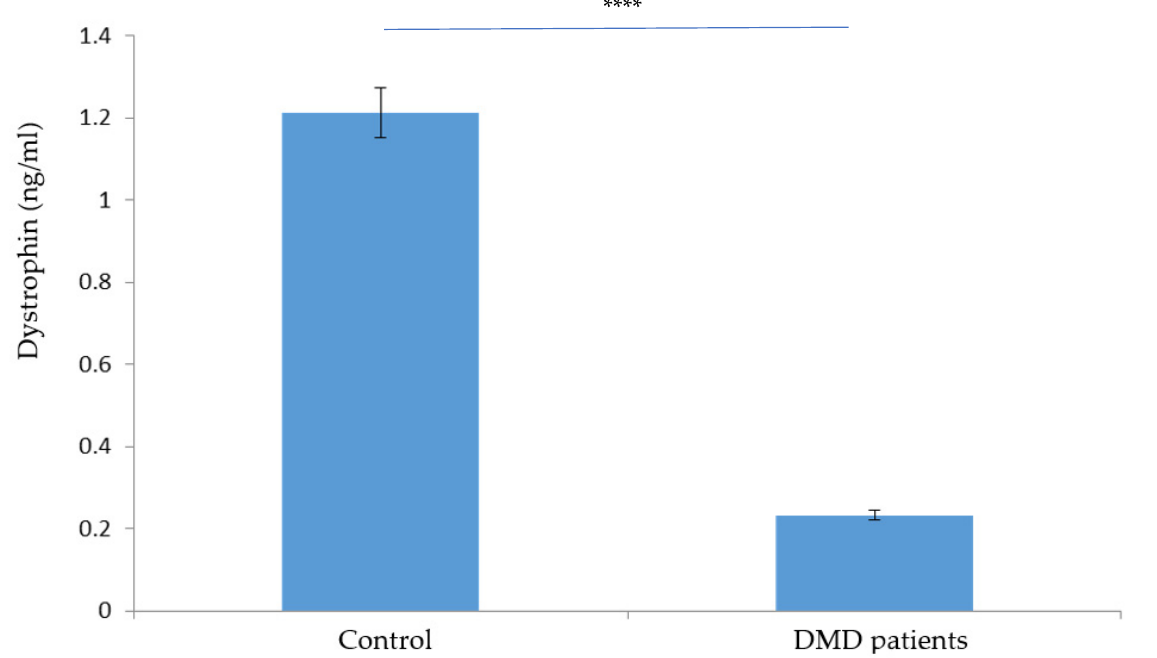
Figure 3. Dystrophin protein level in a DBS. The dystrophin protein level in DMD patients and healthy controls (Ctrl) by ELISA. The difference is statistically significant (****).